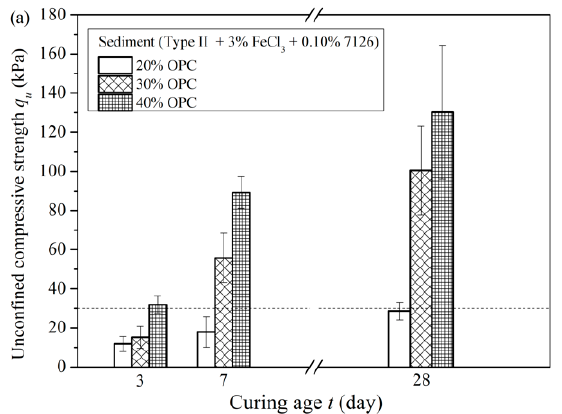
0.0 0.1 0.2 0.3 0.4 0.5 0.6 0.7 0.8 Figure 10. Zeta potential after pretreatment. ( a ) CPAM. ( b ) APAM. ( c ) FeCl 3 + PAM.